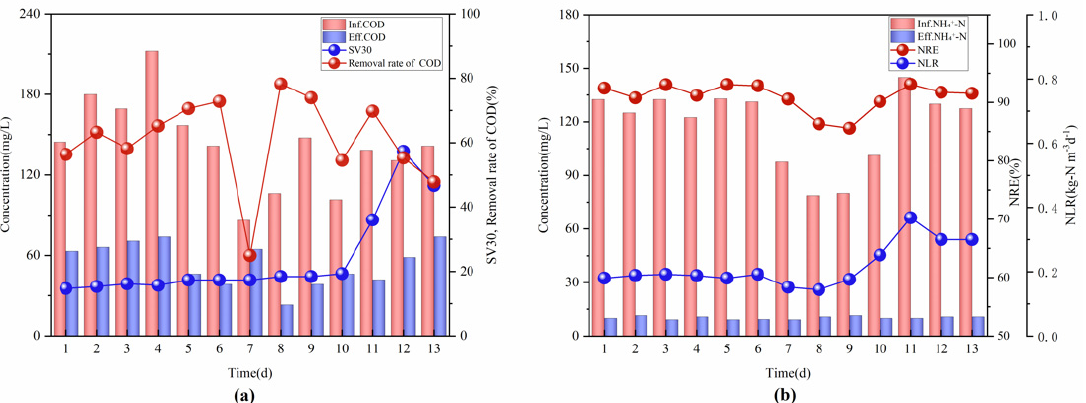
Figure 3. Variation in the indicators during the start-up period: ( a ) concentration of COD, COD removal rate, and SV30 in the inlet and outlet water; ( b ) concentration of NH 4+ -N, NH 4+ -N removal rate (NRE), and NLR in the inlet and outlet